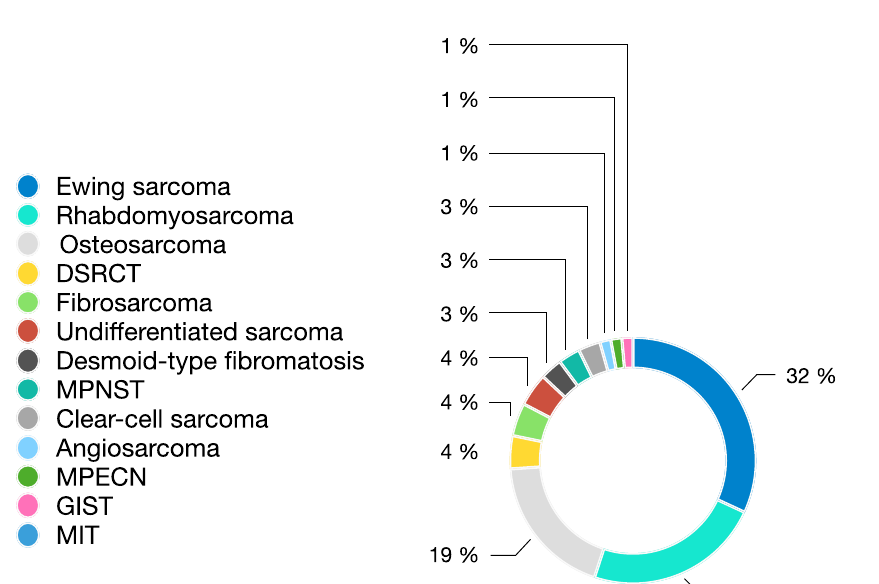
Figure 1. Distribution of sarcoma type amongst reported cases. DSRCT: desmoplastic small round cell tumour; MPNST: malignant peripheral nerve sheath tumour; MPECN: malignant perivascular epithelioid cell neoplasm; GIST: gastrointestinal stromal tumour; MIT: myo-fibroblastic inflammatory tumour.